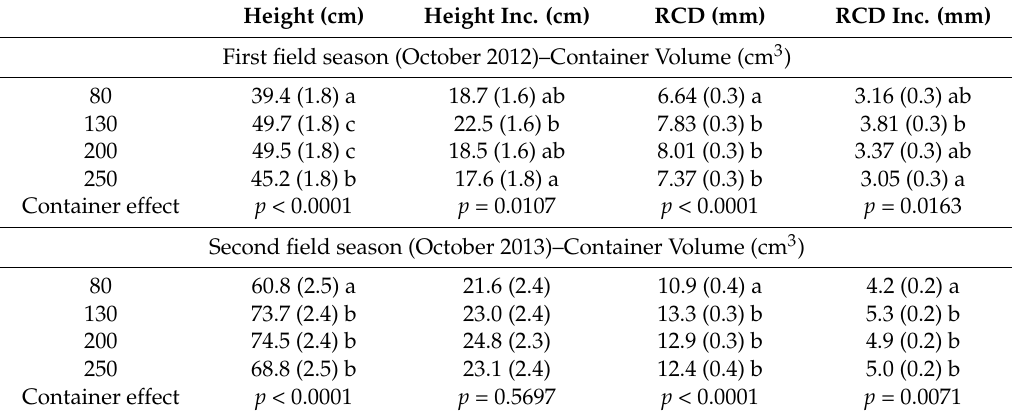
Table 4. Mean ± (SE) height, height increment, root-collar diameter (RCD), and RCD increment of surviving western larch seedlings at end of the first and second field seasons (October 2012 and 2013). Data is from glyphosate-sprayed (GS) plots only due to near complete mortality within the high competition (HC) plots. Different letters within a field season column indicate significant differences at α = 0.05. Height Inc.